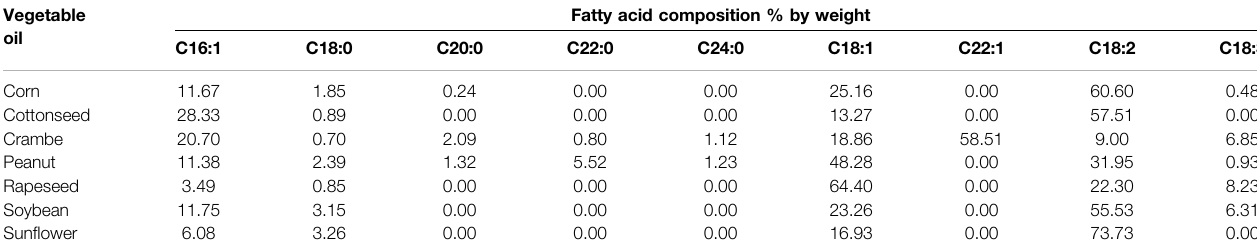
TABLE 1 | Fatty acid composition from different vegetable sources (Marchetti et al., 2007). Vegetable